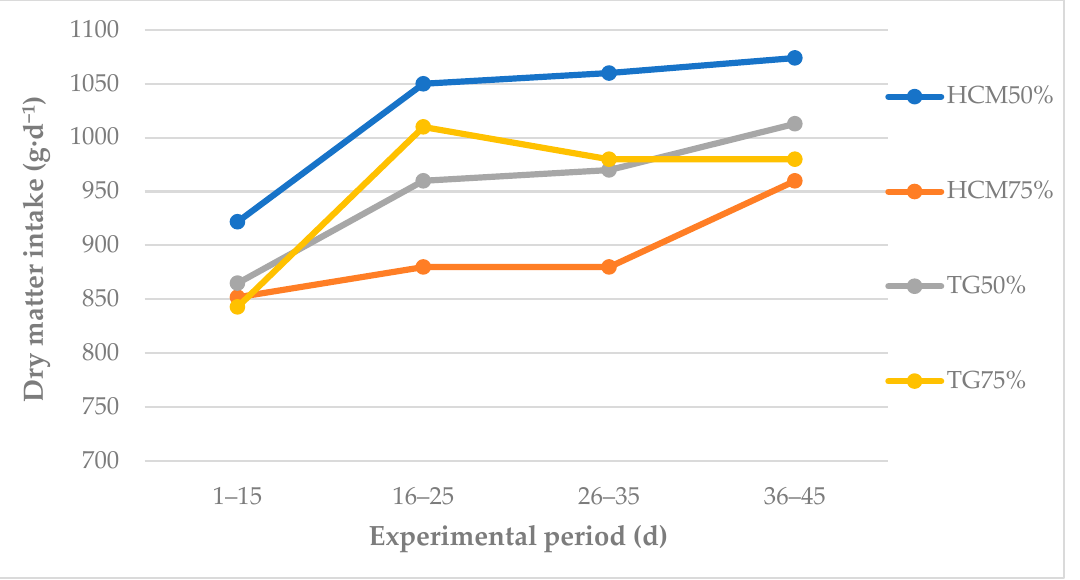
Figure 1. Average daily intake of dry matter (g·d − 1 ) by lambs during the experimental period. HMC—high-moisture corn; TG—triticale grain.